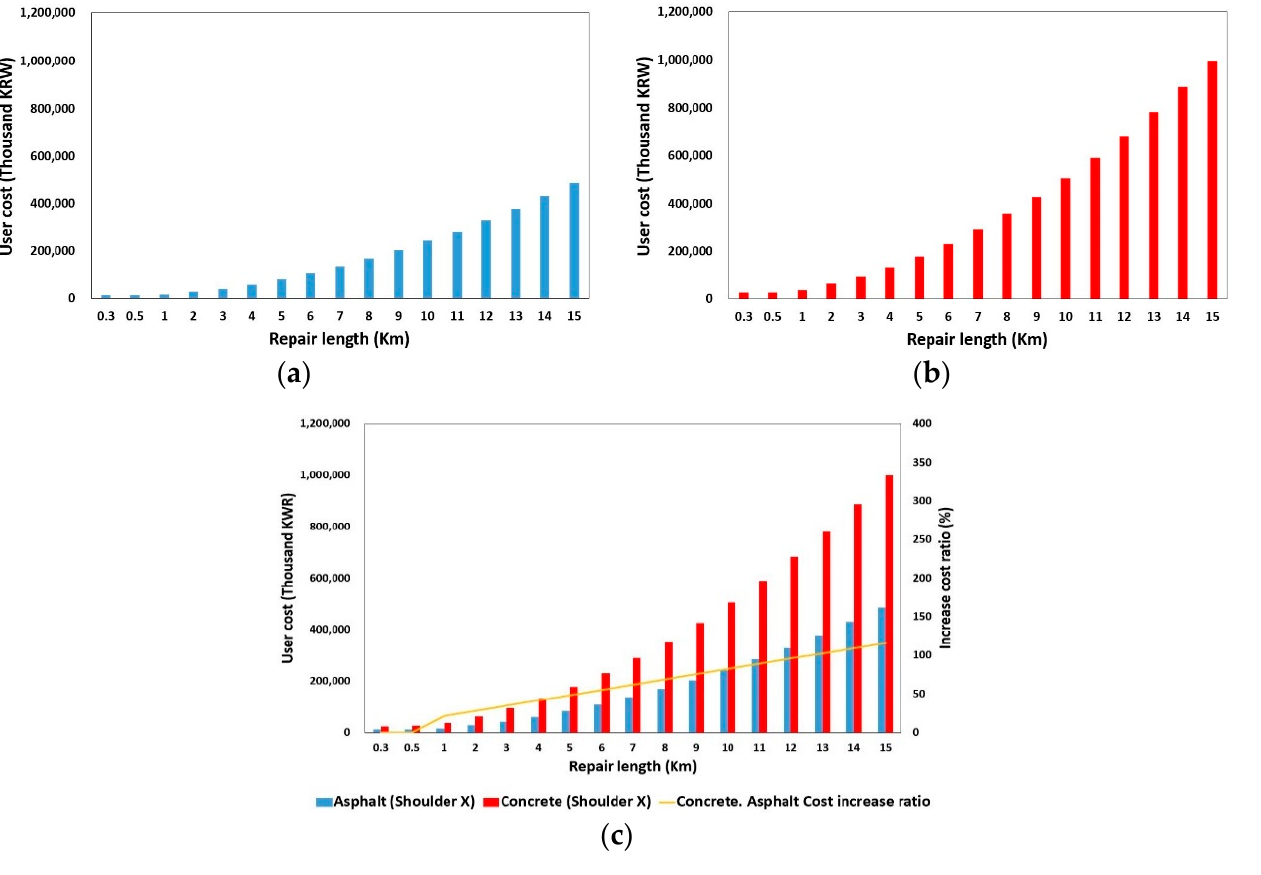
Figure 3. User cost comparison (Shoulder X, 11,000 AADT). ( a ) Asphalt overlay user cost (Shoulder X). ( b ) Concrete overlay user cost (Shoulder X). ( c ) Comparison of overlay user cost (Shoulder X).